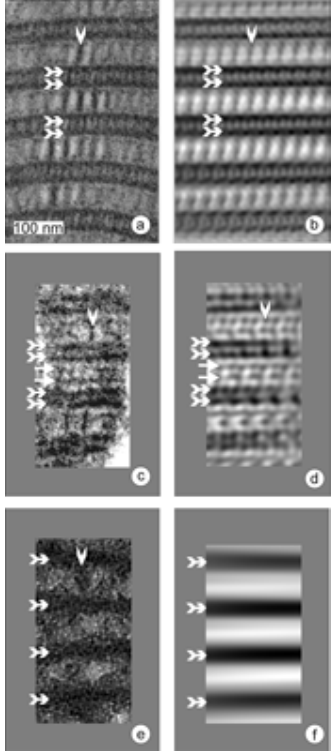
FIGURE 4. (a) Collagen VI network in the vitreous of a patient suffering from Full Thickness Macular Holes. Transverse bands 30 nm apart (double arrows, protein in black) repeat axially with a 100-nm periodicity. Axial filaments run through the bands (chevron). (b) Fourier-filtered image of (a). (c) Collagen VI network in the retina of a patient suffering from Age-Related Macular Degeneration. In addition to the structural characteristics of the aggregates described in (a), extra transverse bands of protein density run between the main pairs of bands (single arrows). (d) Fourier-filtered image of (c). (e) Collagen VI network in the retina of a patient suffering from Sorsby’s Fundus Dystrophy. Here the transverse double bands are fused into a single broad band (double arrows). (f) Fourier-filtered image of (e).